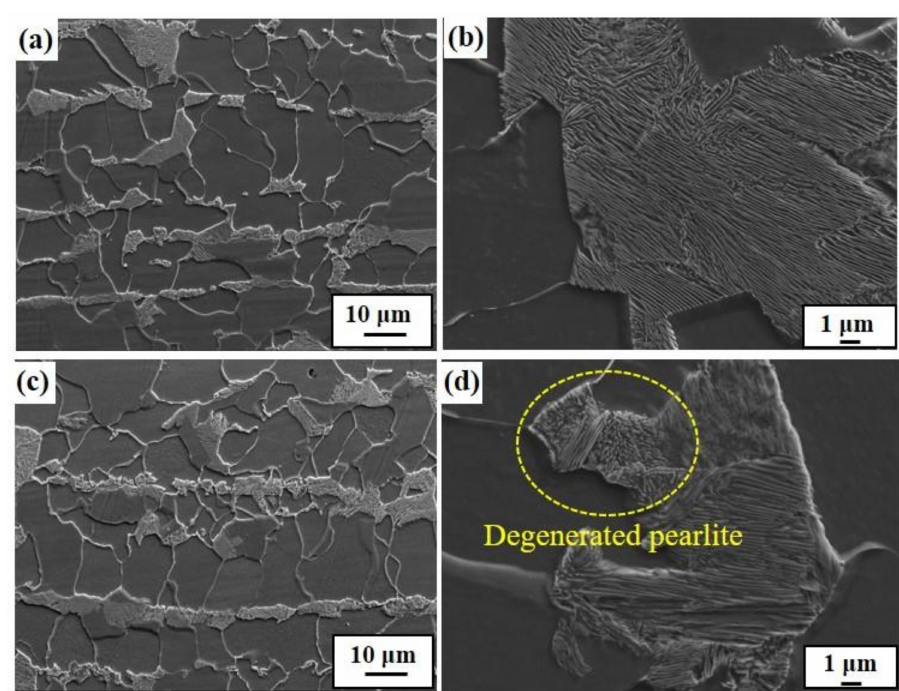
Figure 5. Microstructure observation of Steel C using FE-SEM: ( a ) surface region, ( b ) magnified image of ( a ), ( c ) center region, and ( d ) magnified image of ( c